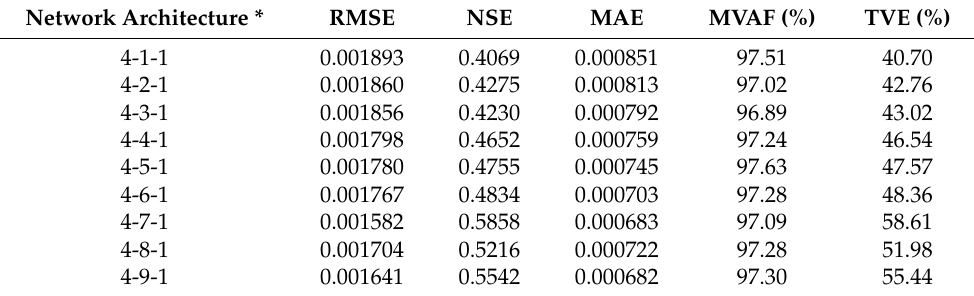
Table 2. Results of the BPNN model with different network architectures.